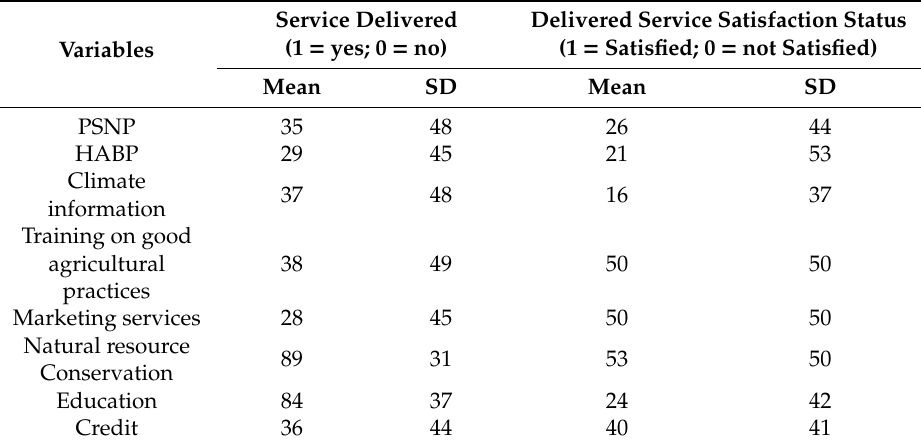
Table 2. Institutional service delivery and level of community